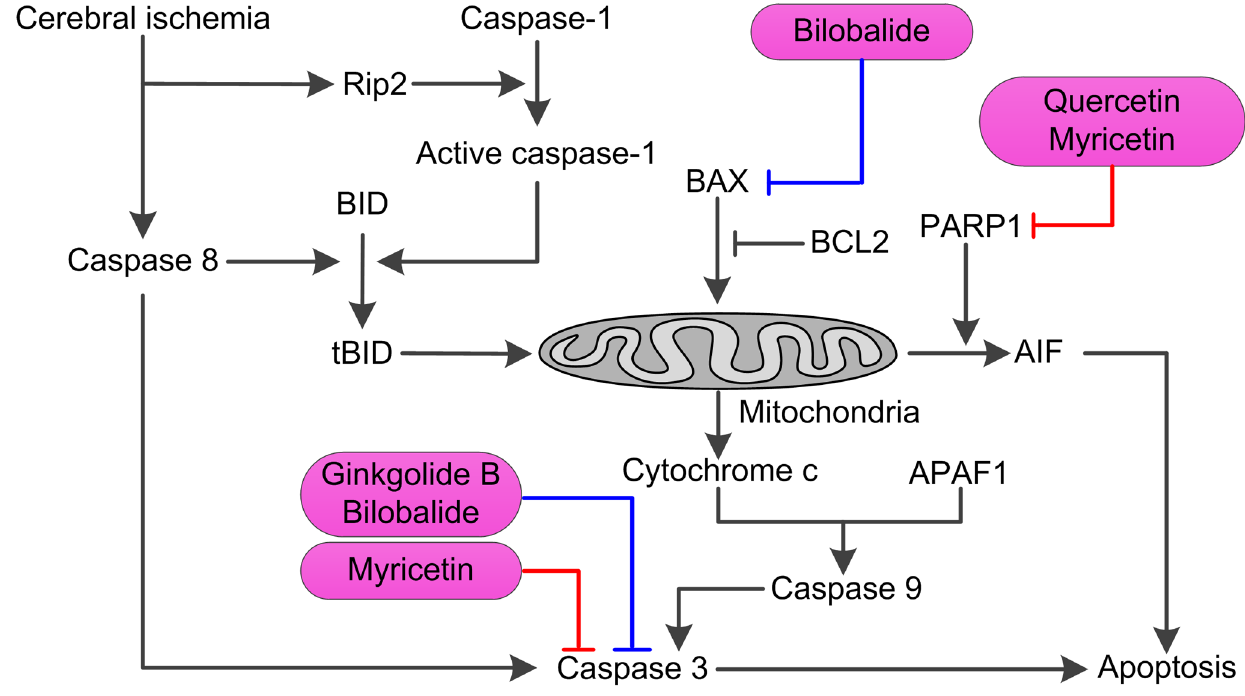
Figure 6. Illustrating the synergistic actions of anti-apoptosis of Ginkgobiloba .